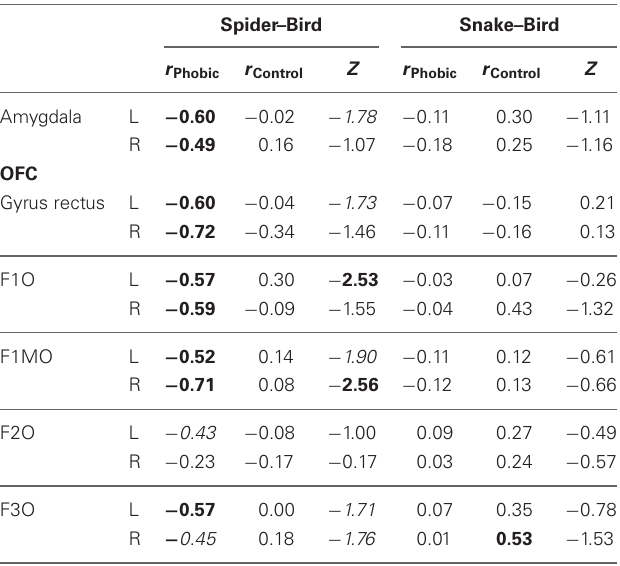
Table 2 | Correlations between gaze duration spider – bird / snake – bird and BOLD contrast spider – bird / snake – bird ; ROI analysis.